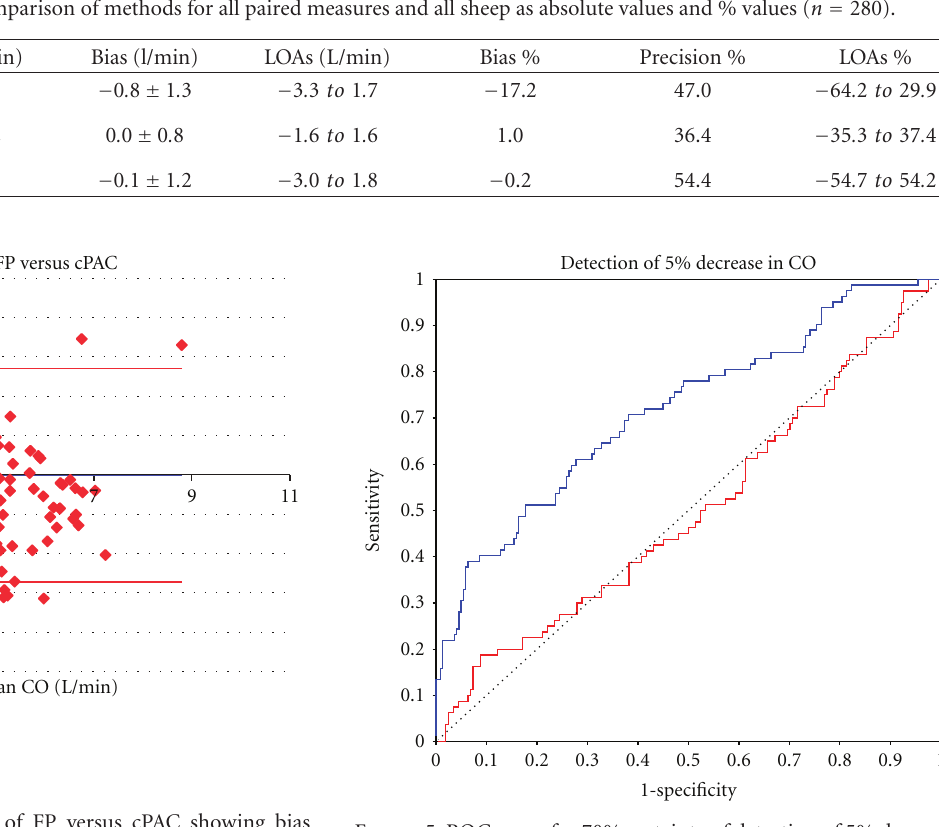
Figure 5: ROC curve for 70% certainty of detection of 5% decrease in CO from baseline with PAC in red (AUC = 0 . 496), USCOM in blue (AUC = 0 . 715). Random values are represented by the dotted line (AUC = 0 . 50) and clinical e ff ectiveness AUC ≥ 0 .